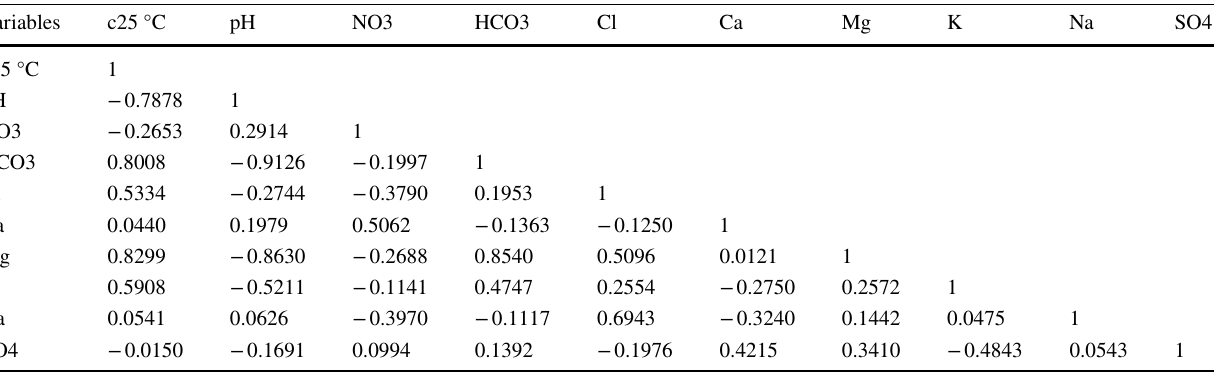
Table 3 Correlation matrix between measured parameters